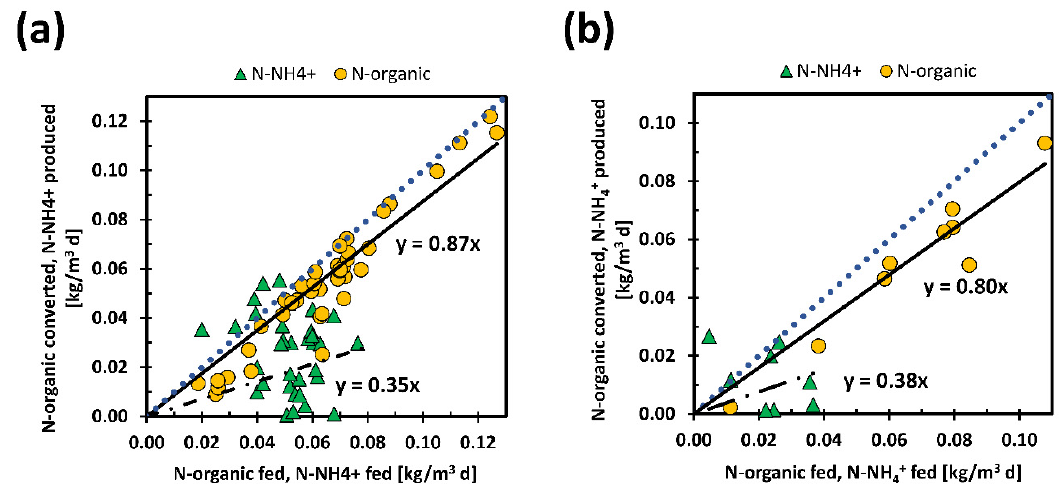
Figure 4. Conversion rates of N-organic in N-NH 4+ with TBSS ( a ) and with DBSS ( b ). The black lines represent the fittings